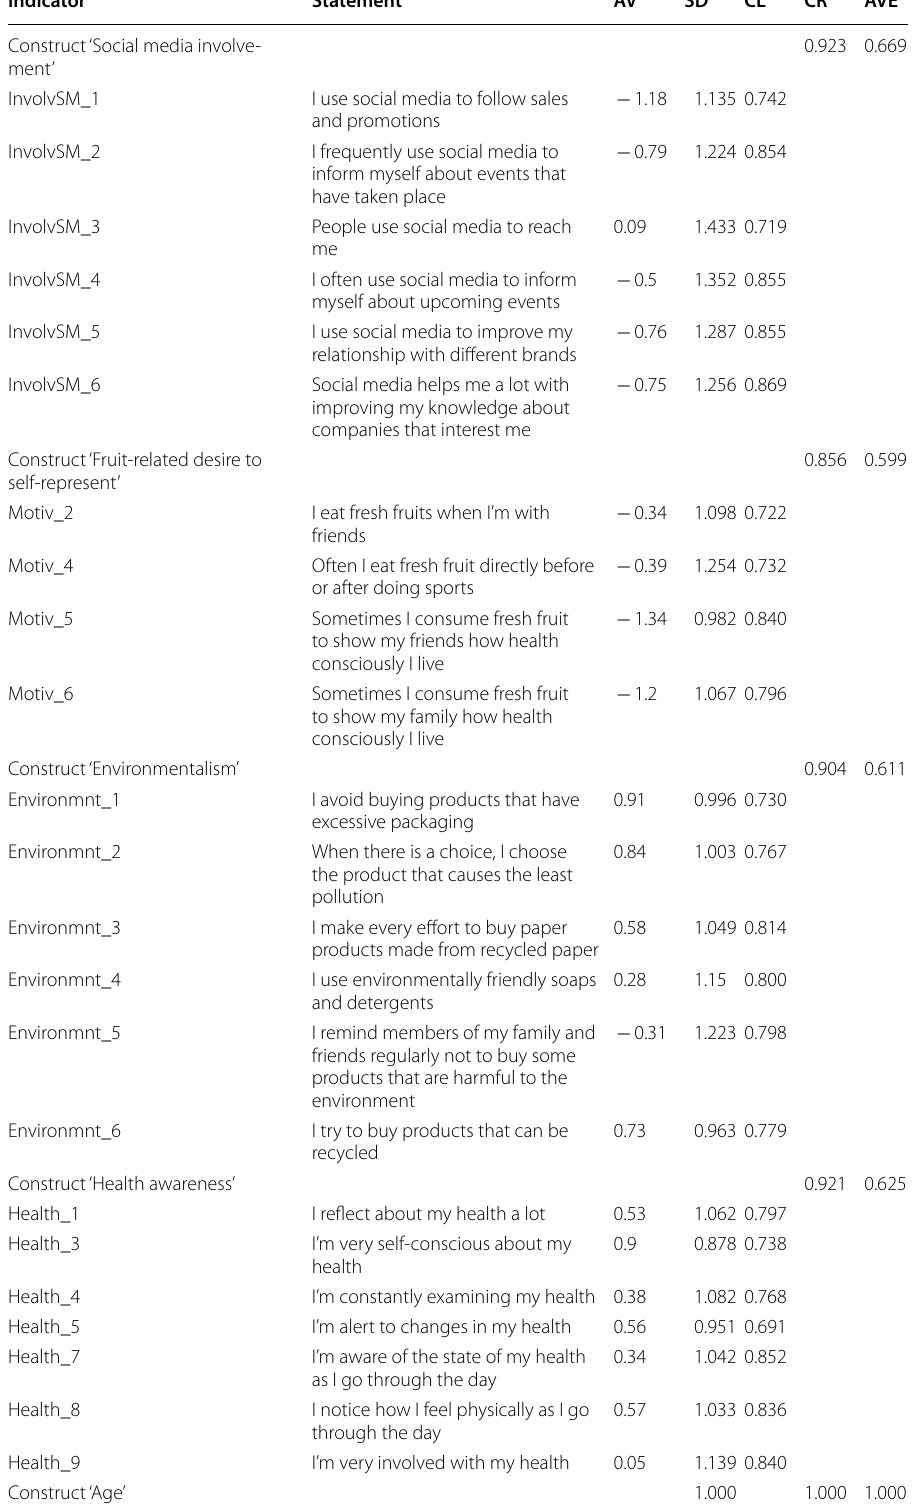
Table 1 Reliability of the research model Source: Authors’ own calculation